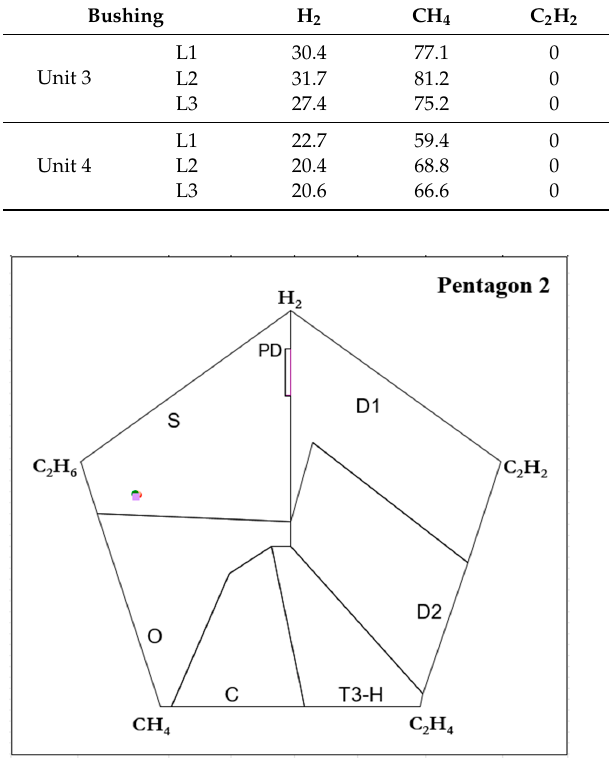
Figure 4. SG patterns of DDB oil in bushings of RWE in service (units 3–4).